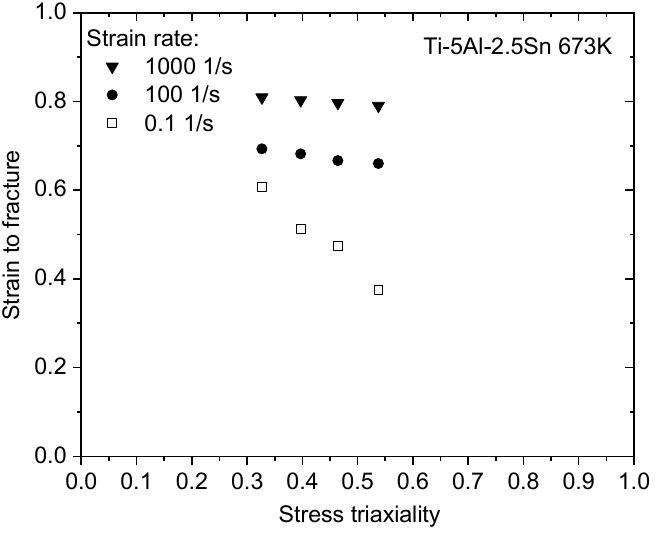
Figure 8. Strain-to-fracture ratio of Ti-5Al-2.5Sn at a temperature of 673 K, strain rates ranging from 0.1 to 10 3 s − 1 , and stress triaxiality ranging from 0.3 to 0.5.